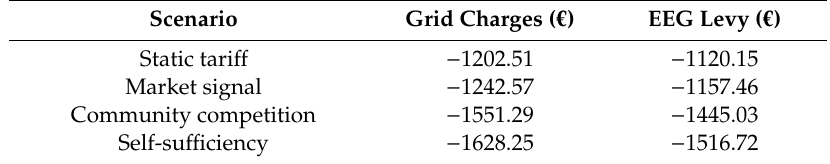
Table 9. Collected EEG levy and grid charges by the policy agent relative to the BAU